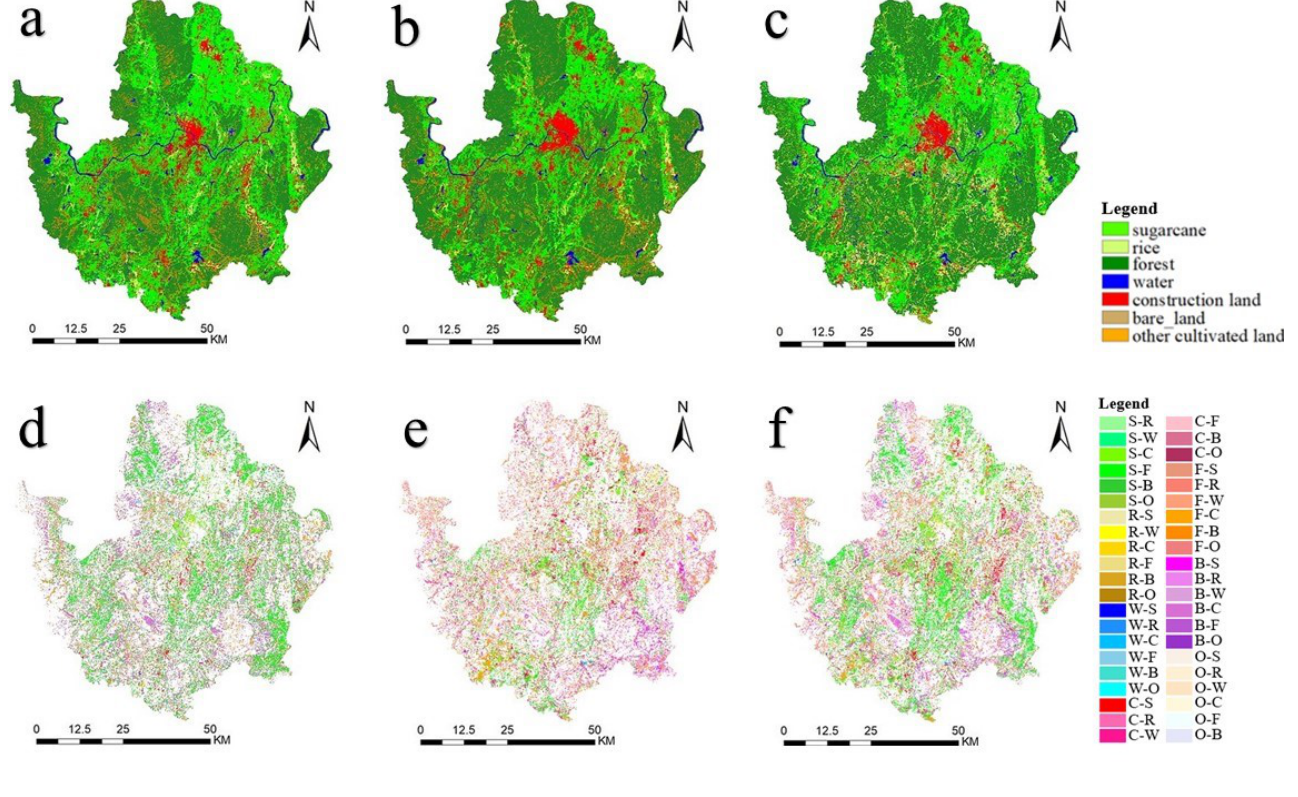
Figure 5. Spatial and temporal distribution of land use in 2010 ( a ); 2015 ( b ); 2019 ( c ); Land use